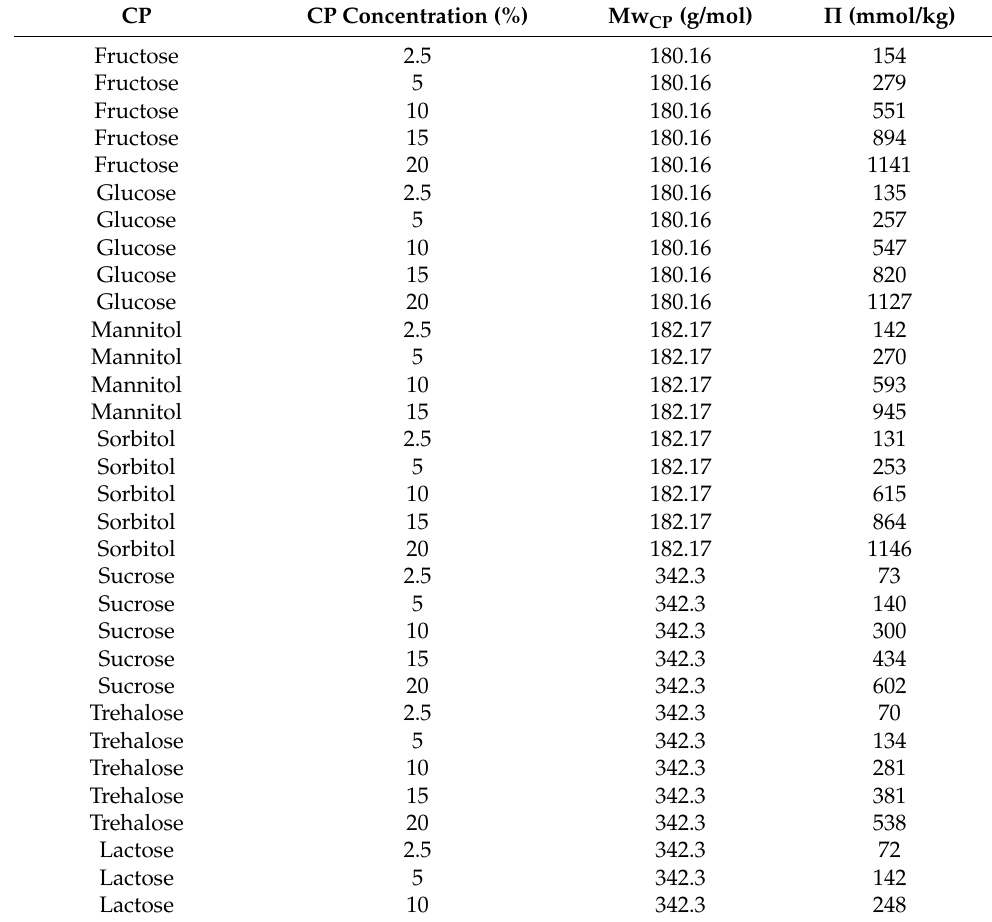
Table 1. Variables included as inputs for modelling: CP type, CP concentration, MW CP, and osmolar- ity in aqueous